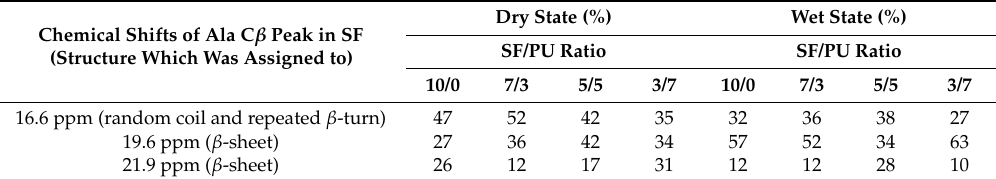
Table 2. Fraction of the random coil and the β -turn structure (16.6 ppm) and the β -sheet structure (19.6 ppm and 21.9 ppm) of SF/PU composite sheets. Determined by the deconvolution of the Ala C β peaks in wet and dry